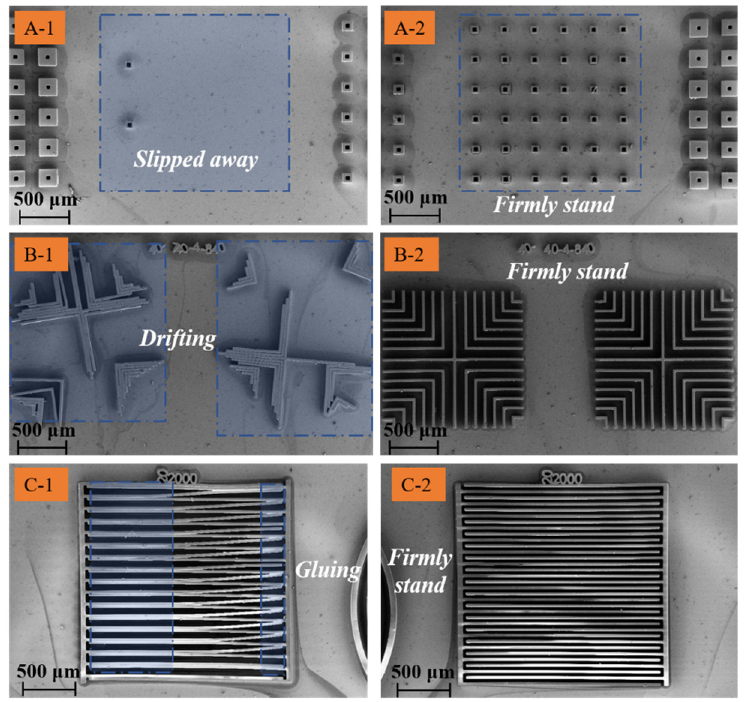
Figure 10. SEM of different SU-8 microstructures IPS ( A-1 – C-1 ) and with strengthening layer on IPS ( A-2 – C-2 ). on IPS ( A-2 – C-2 ).